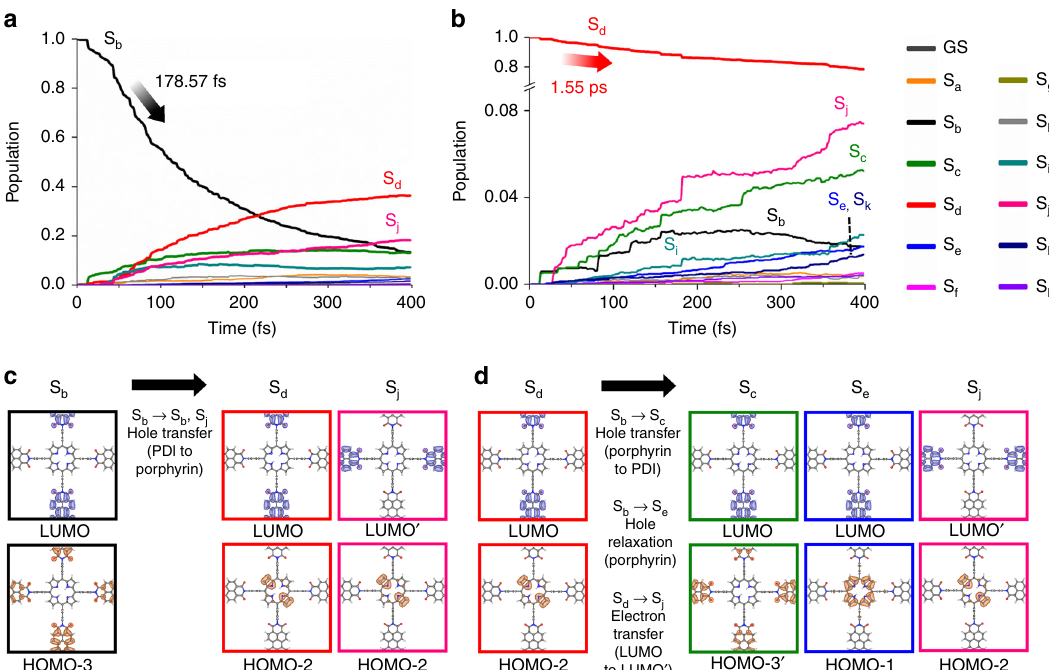
Fig. 4 Ab initio non-adiabatic molecular dynamics simulations. a Time evolution of electronic populations starting from the initially excited S b state, where the charge carriers are localized in the PDI moieties. b Time evolution of electronic populations starting from the hole-transferred state (S d ), describing the dynamics of charge carriers after PDI-to-porphyrin hole transfer. c Evolution of electron-hole distribution starting from the initially excited S b state, visualized with the Kohn – Sham (KS) orbitals of COFs. In each of HOMO and LUMO, the densities of holes (orange) and electrons (blue) are depicted. All possible electron-hole pairs in the active space are listed in Supplementary Table 2. d Evolution of electron-hole distribution starting from the hole-transferred state S d . In each of HOMO and LUMO, the densities of holes (orange) and electrons (blue) are